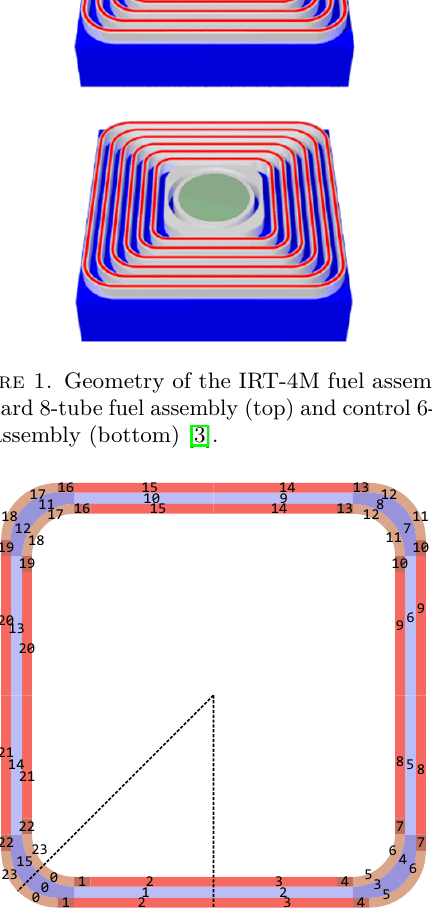
Figure 2. Radially-azimuthal view of the computa- tional